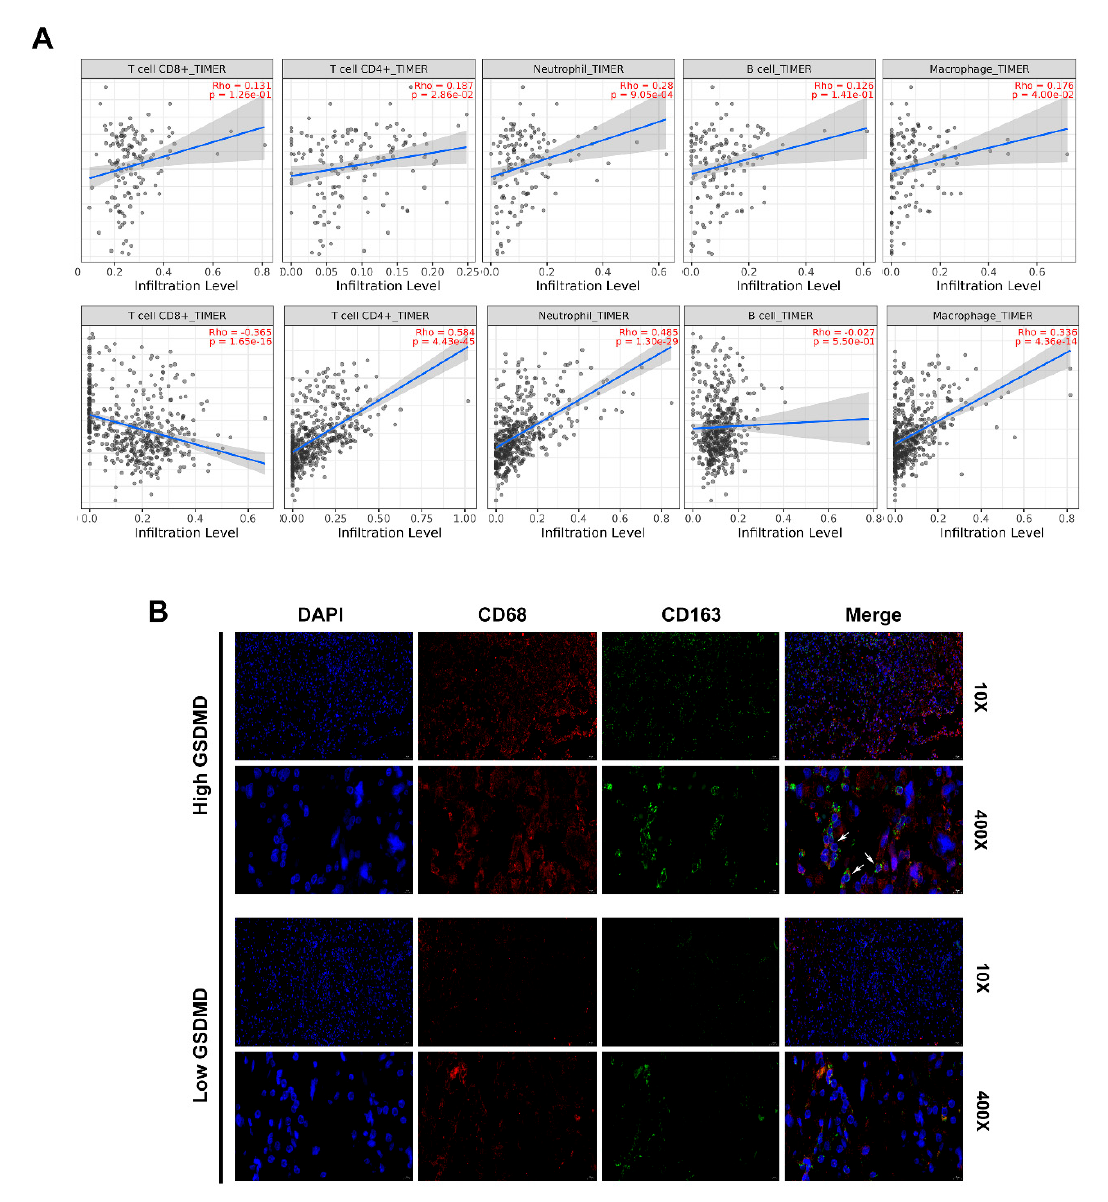
Figure 7. GSDMD associated with immune cell infiltration in glioma ( A ). TIMER was used to assess the association between GSDMD expression and immune cell infiltration in LGG and GBM. ( B ). Immunofluorescence double-staining for CD68 and CD163 in glioma tissues with high or low GSDMD expression. White arrows indicate CD68+/CD163+ cells. Nuclei were detected by DAPI staining.